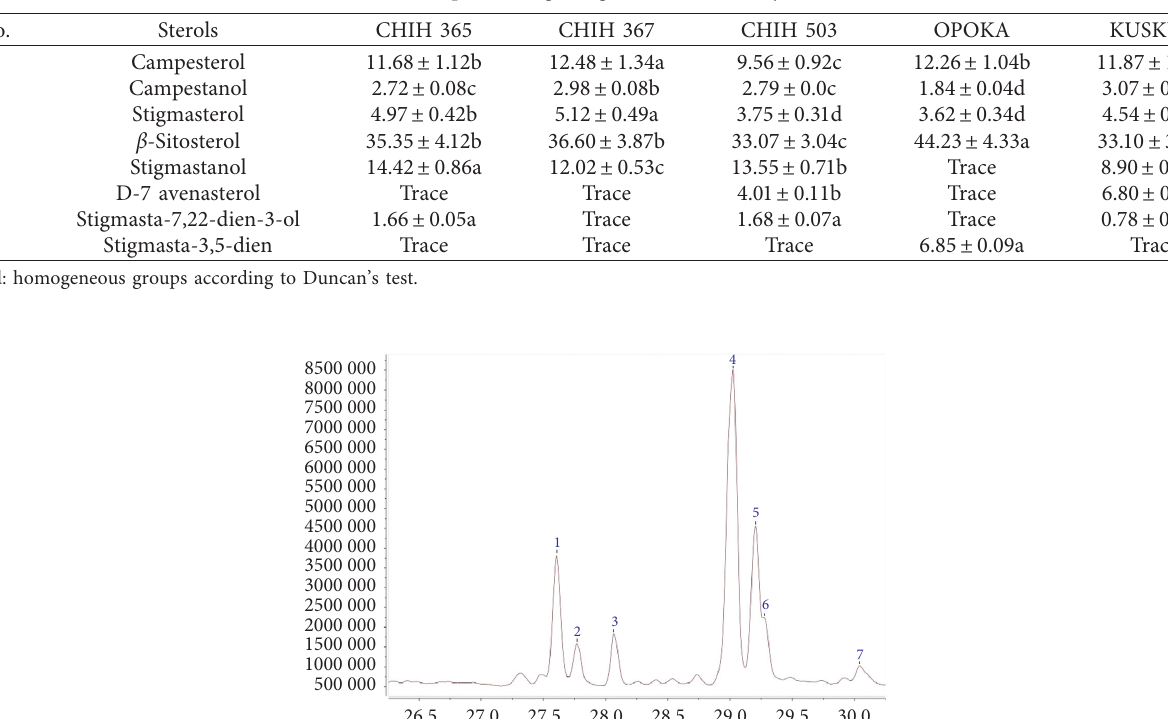
Table 2: Sterol profile (mg/100 g) of the blue and yellow corn.